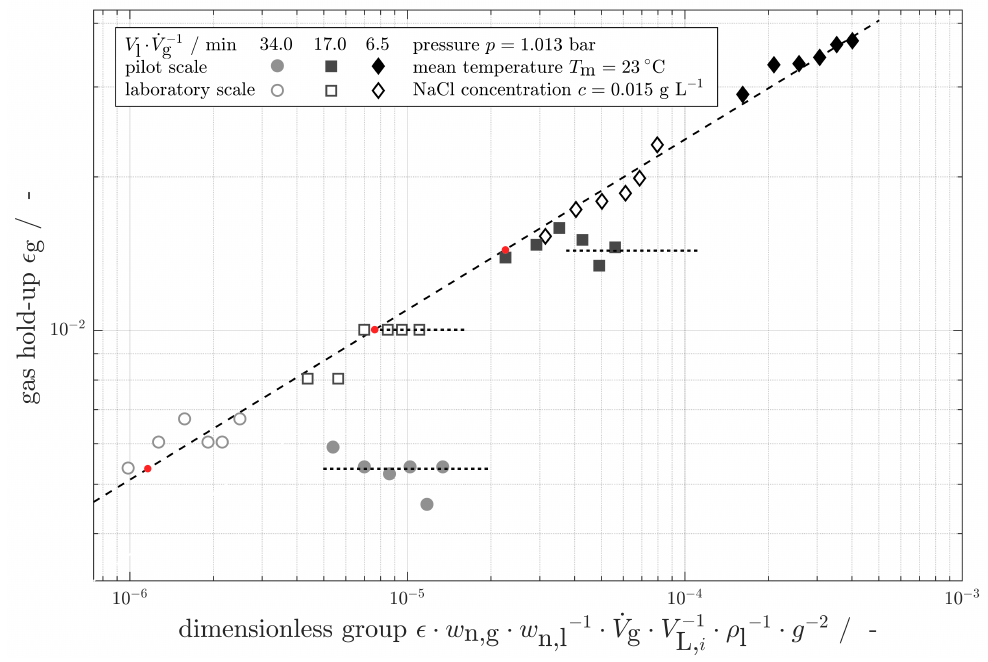
Figure 7. Recorded gas hold-ups (cid:101) g for both systems in dependence of the formulated dimensionless group (Equation (14)). Transition points to saturated states marked as red